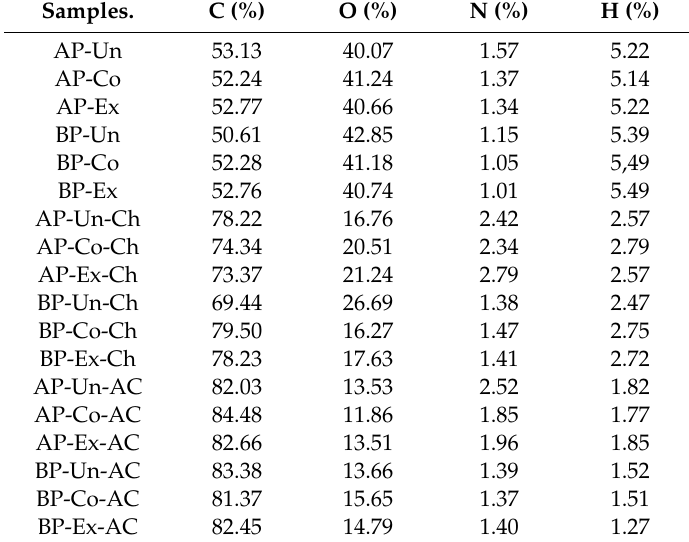
Table 2. Elemental composition of piassava fibers (untreated and pretreated), charcoal and activated